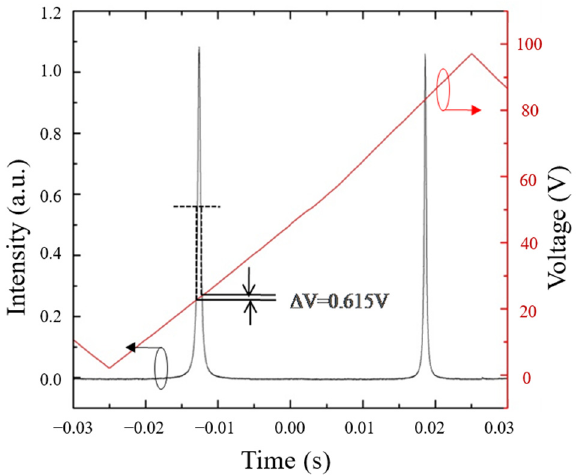
Figure 4. Curve fitting of the resonant spectrum ( g 1 = 6.9 μ m and g 2 = 6.7 μ m).